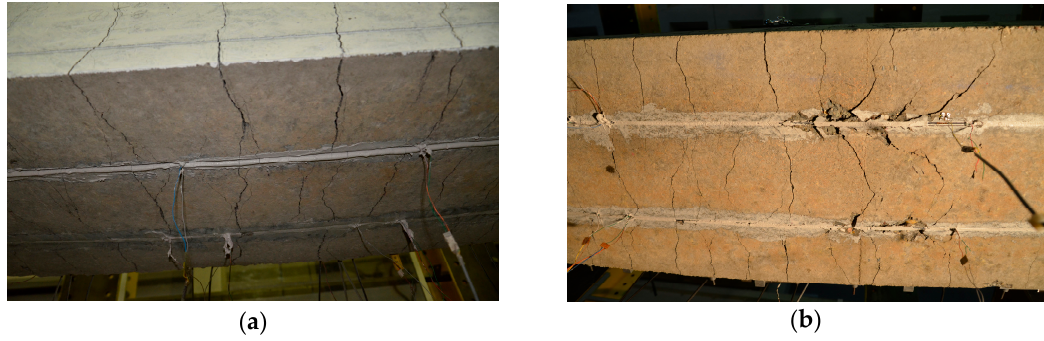
Figure 8. Cracking pattern on the bottom surface of beams of series B: ( a ) NSM12B; and ( b ) NSM12B-L.